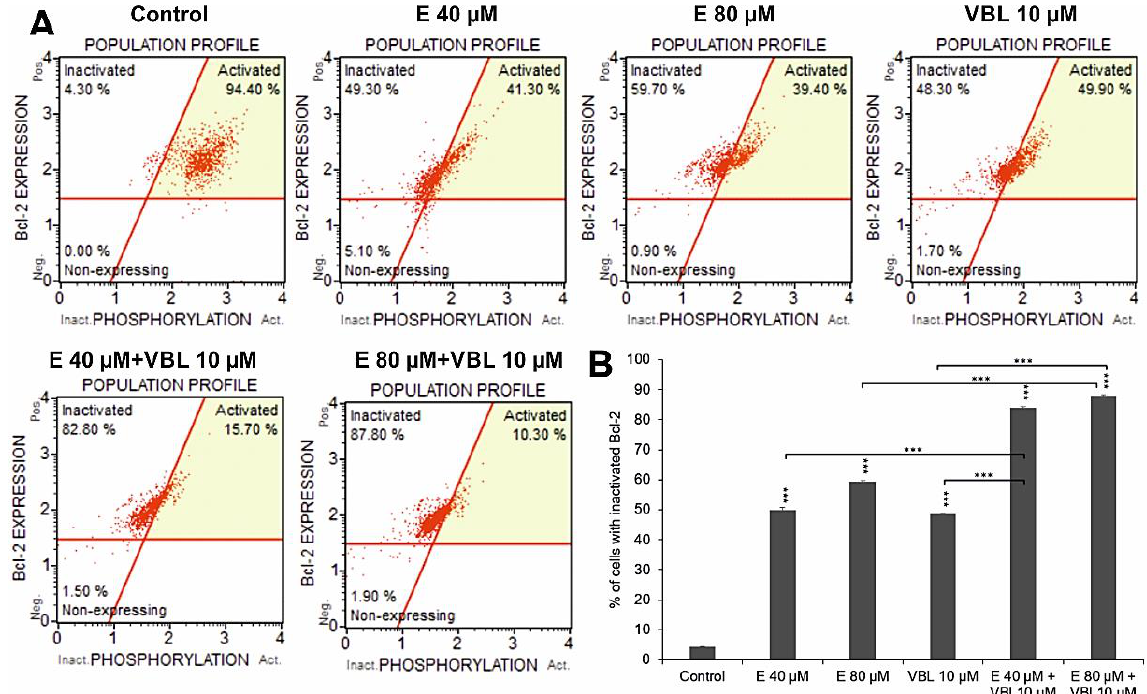
Figure 3. Dependence on the concentration of emodin and vinblastine percent of cells with inactivated Bcl-2 protein ( A ). Percentage of cells with Bcl-2 protein inactivation ( B ). The data in the graph show the mean ± SE of three independent experiments. Differences statistically confirmed at: *** p < 0.001.